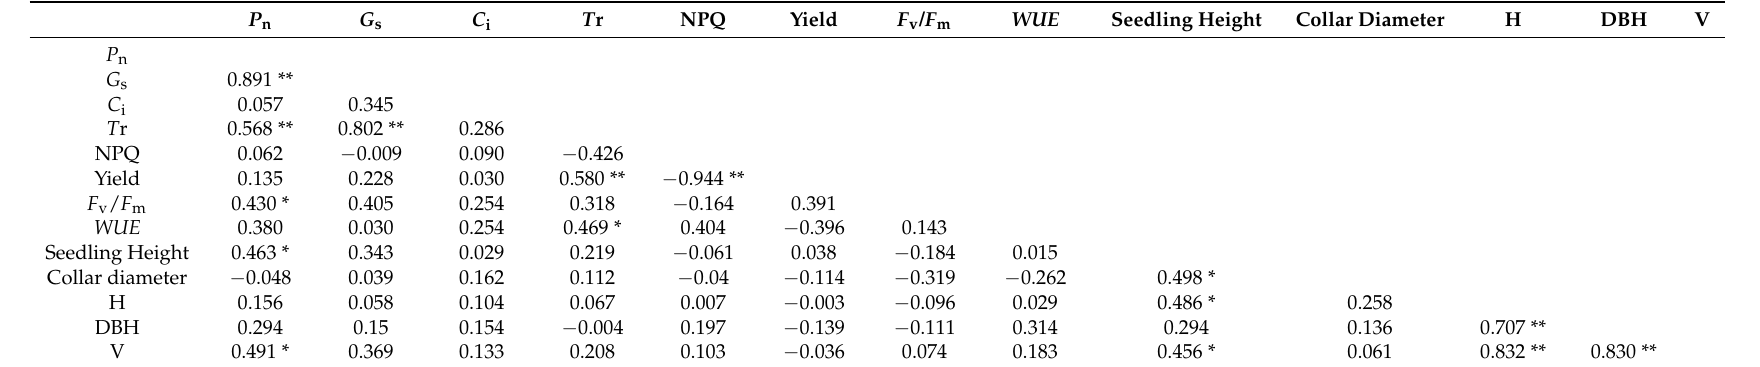
Table 9. Correlation analysis among photosynthetic characteristics, growth traits, and ecological factors of teak